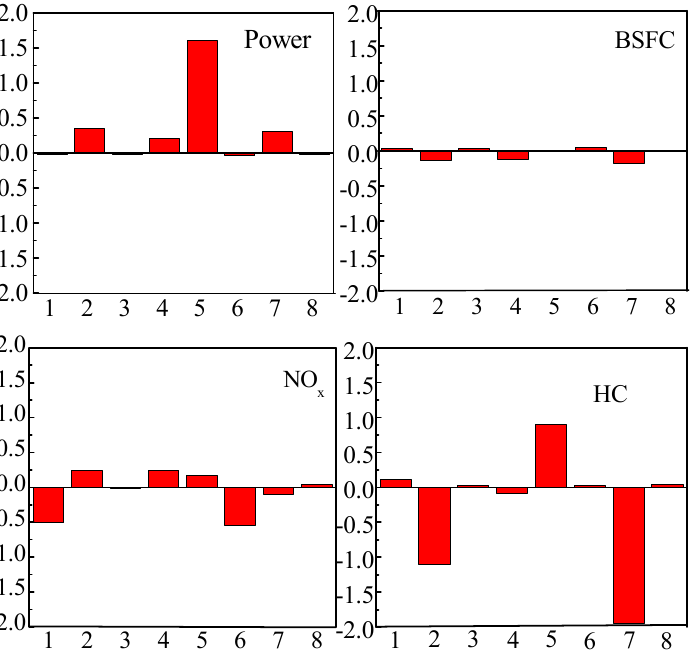
Figure 14. Comparisons of relative contribution on the engine characteristic in in high speed (1000 rpm) and lean operation zone (Equivalence ratio Φ = 0.75).